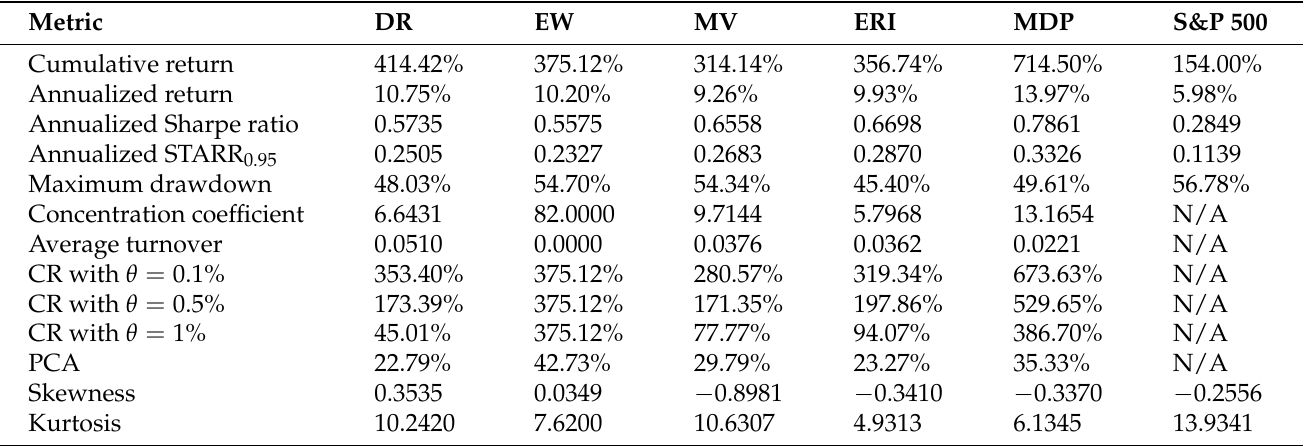
Figure A5. Portfolio values for grouped stocks with tail indices α > 3.5. Table A3. Performance comparisons for DR, EW, MV, ERI, MDP, and S&P 500 index for stocks with α >